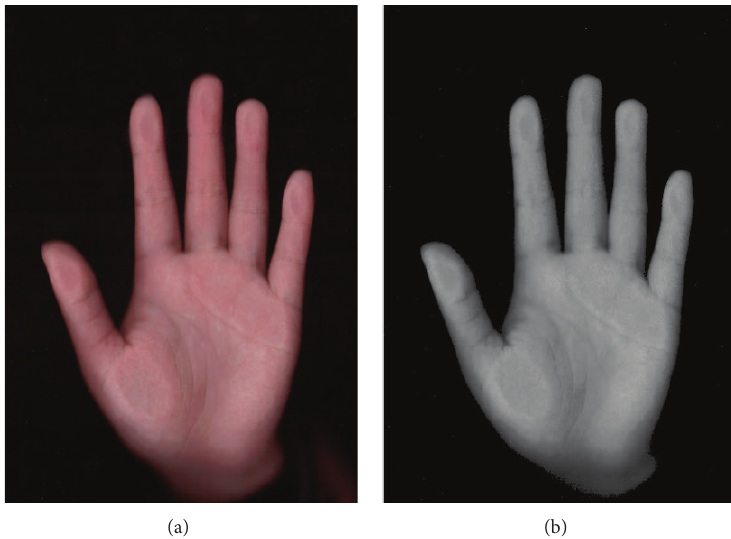
Figure 6: (a) The original image and (b) the gray image of (a).